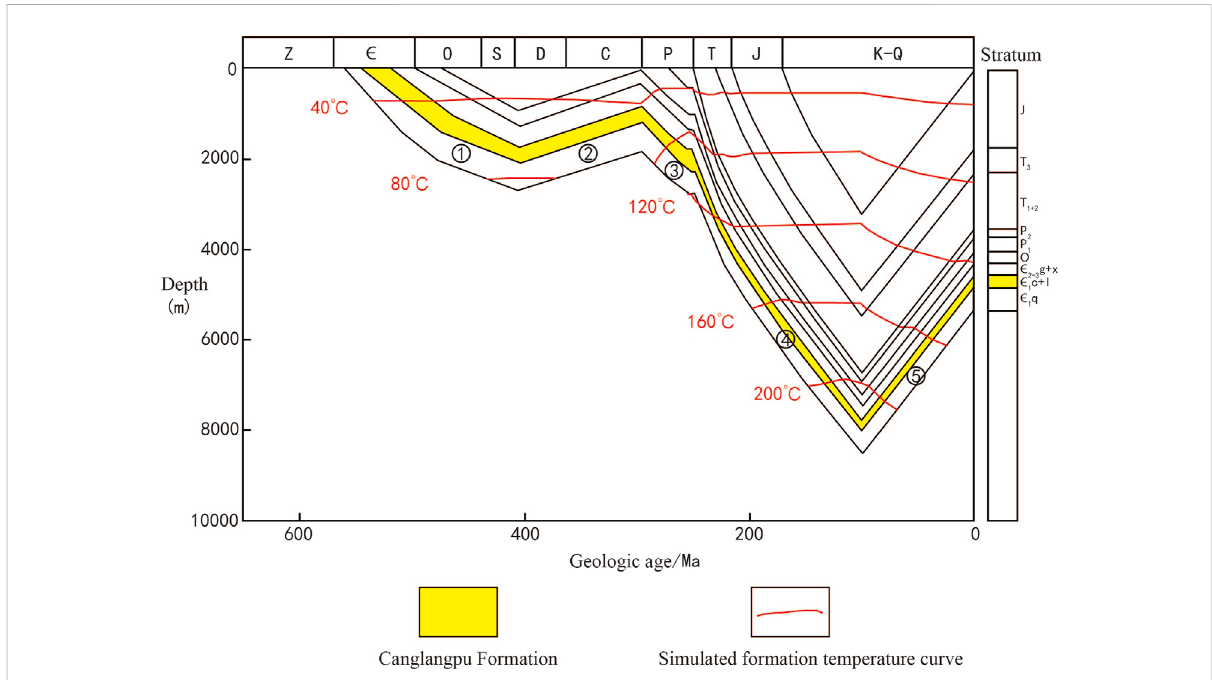
FIGURE 5 Burial history of theQiongzhusiFormation inWell GS17 in the Central Sichuan Paleo-uplift (modi fi ed from reference Yang et al., 2020). ① :The fi rst stable settlement-sedimentation period; ② : The fi rst stable uplift period; ③ : The second rapid settlement-sedimentation period; ④ : The third rapid settlement-sedimentation period; ⑤ The second rapid uplift